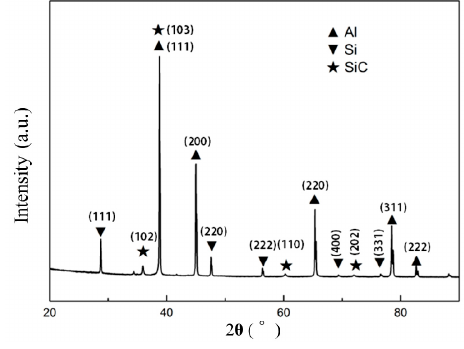
Figure 4. XRD of the PM SiC p /Al-Si